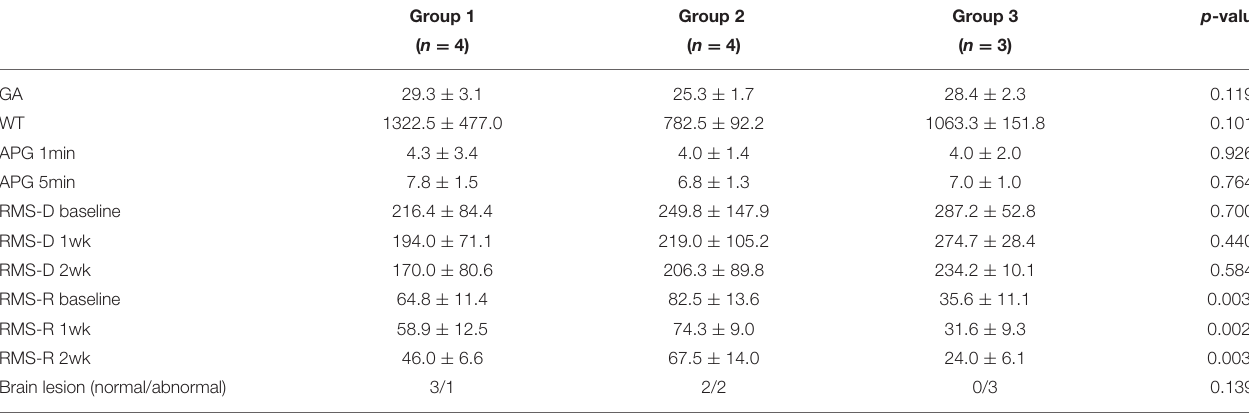
TABLE 4 | Clinical variables according to development